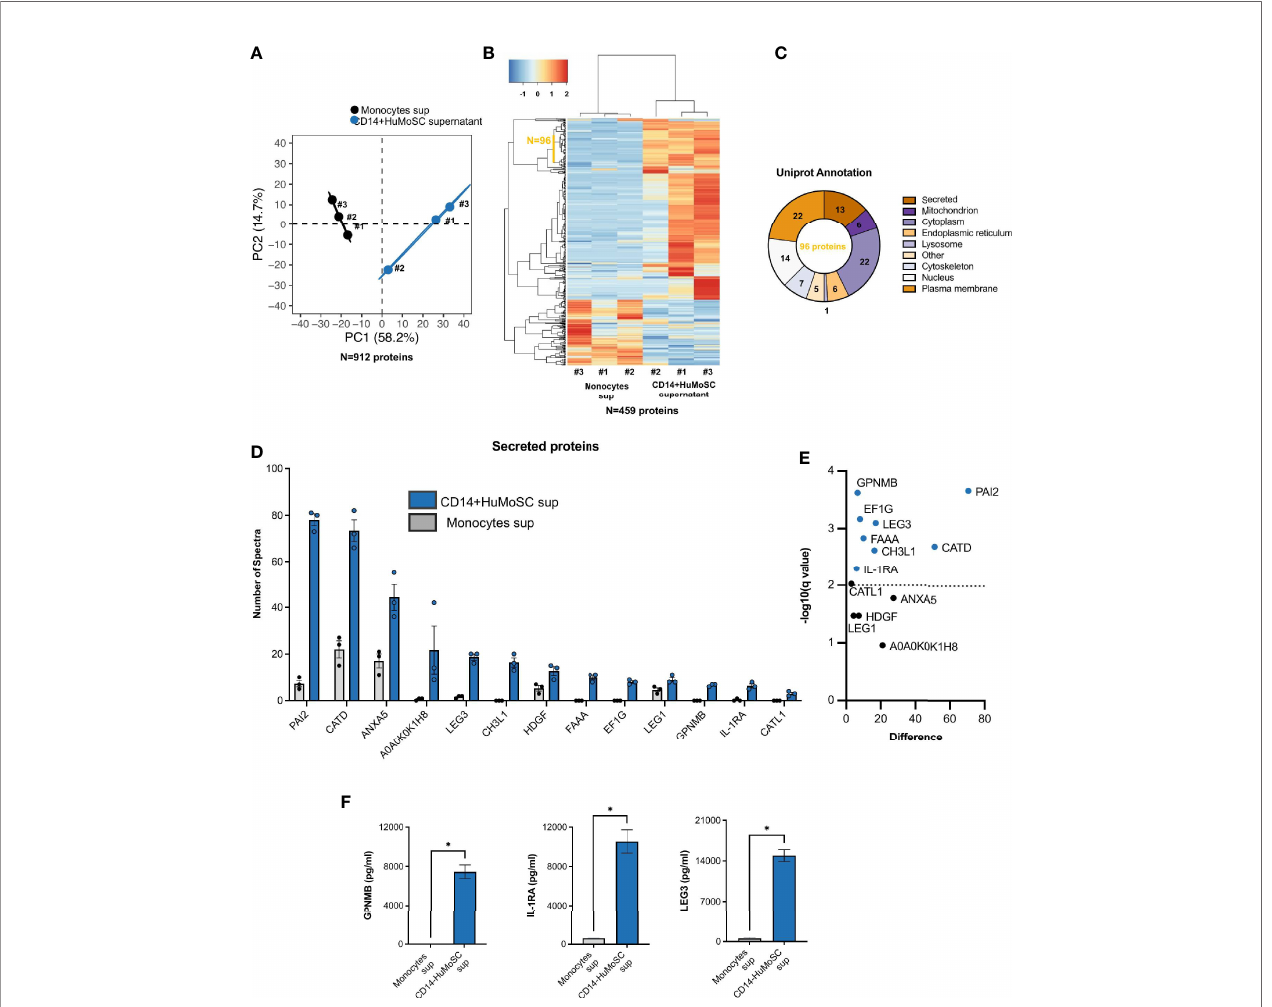
FIGURE 7 | Proteomic analysis of CD14+HuMoSC supernatant composition compared with monocyte supernatant. Supernatants were produced by either undifferentiated monocytes or CD14+HuMoSC from 3 healthy volunteers and proteomic analysis was performed in order to characterize CD14+HuMoSC secretome. (A) Principal Component Analysis performed on 912 individual proteins. (B) Unsupervised heatmap of differentially secreted proteins revealed 96 consistently oversecreted proteins in CD14+HuMoSC supernatant. (C) Uniprot annotation revealed subcellular location of each of the 96 CD14+HuMoSC-speci fi c proteins and revealed 13 secreted proteins. (D, E) Relative quanti fi cation of the 13 CD14+HuMoSC-speci fi c secreted proteins with signi fi cant variation. (F) Con fi rmation of the composition of CD14+HuMoSC supernatant using Luminex Asssay. Comparaison of CD14+HuMoSC and monocyte (control) supernatants for IL-1RA, GPNMB and Galectin-3 secretions. Data for 3 independent experiments are shown. Data are shown as means ± SEM. Two-tailed Mann-Whitney test *p <